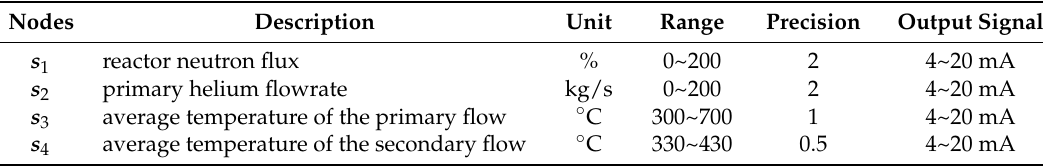
Table 1. Available sensor nodes for